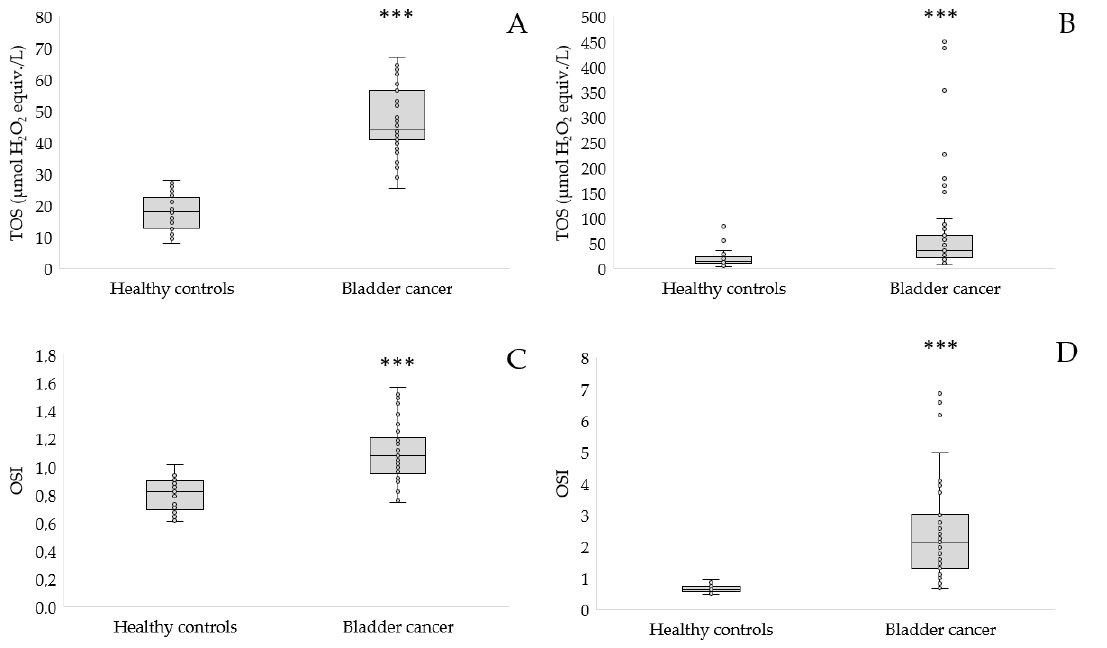
Figure 4. TOS in serum ( A ), urine ( B ), and OSI in serum ( C ), urine ( D ) of patients with bladder cancer in comparison to the controls; *** p < 0.001.